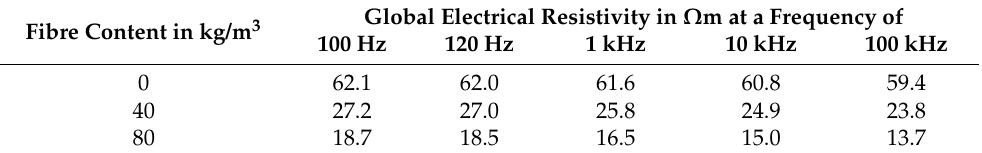
Table A52. Results of the resistivity measurements of the concrete mixture 32-60-300-00 after storage in synthetical pore solution for 185 days for the investigations of possible leaching effects.